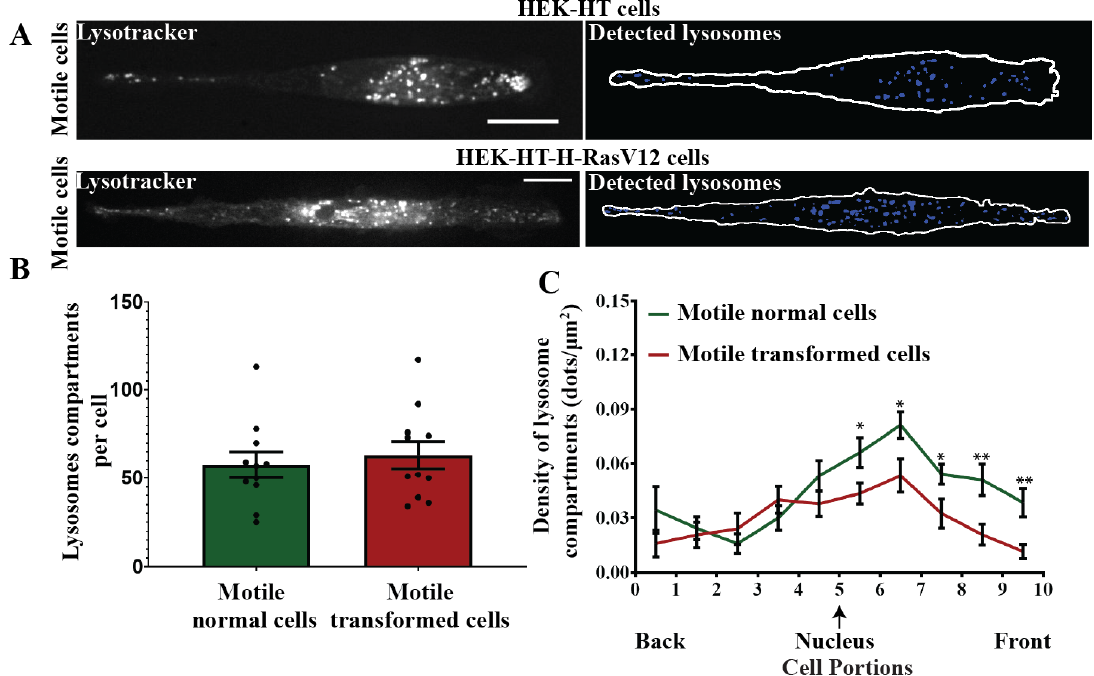
Figure 6. Spatial localization of lysosomes during directional migration: comparison between normal and transformed cells. ( A ) Representative normal HEK-HT and transformed HEK-HT-HRasV12 cells displaying lysotracker staining (left panel) and the seg- mented lysosomes (right panel). ( B ) Graph represents total lysosome compartments per cell in normal and transformed cells. ( C ) Graph represents spatial back–front topology of lysosome distribution during directional migration in normal and transformed cells.